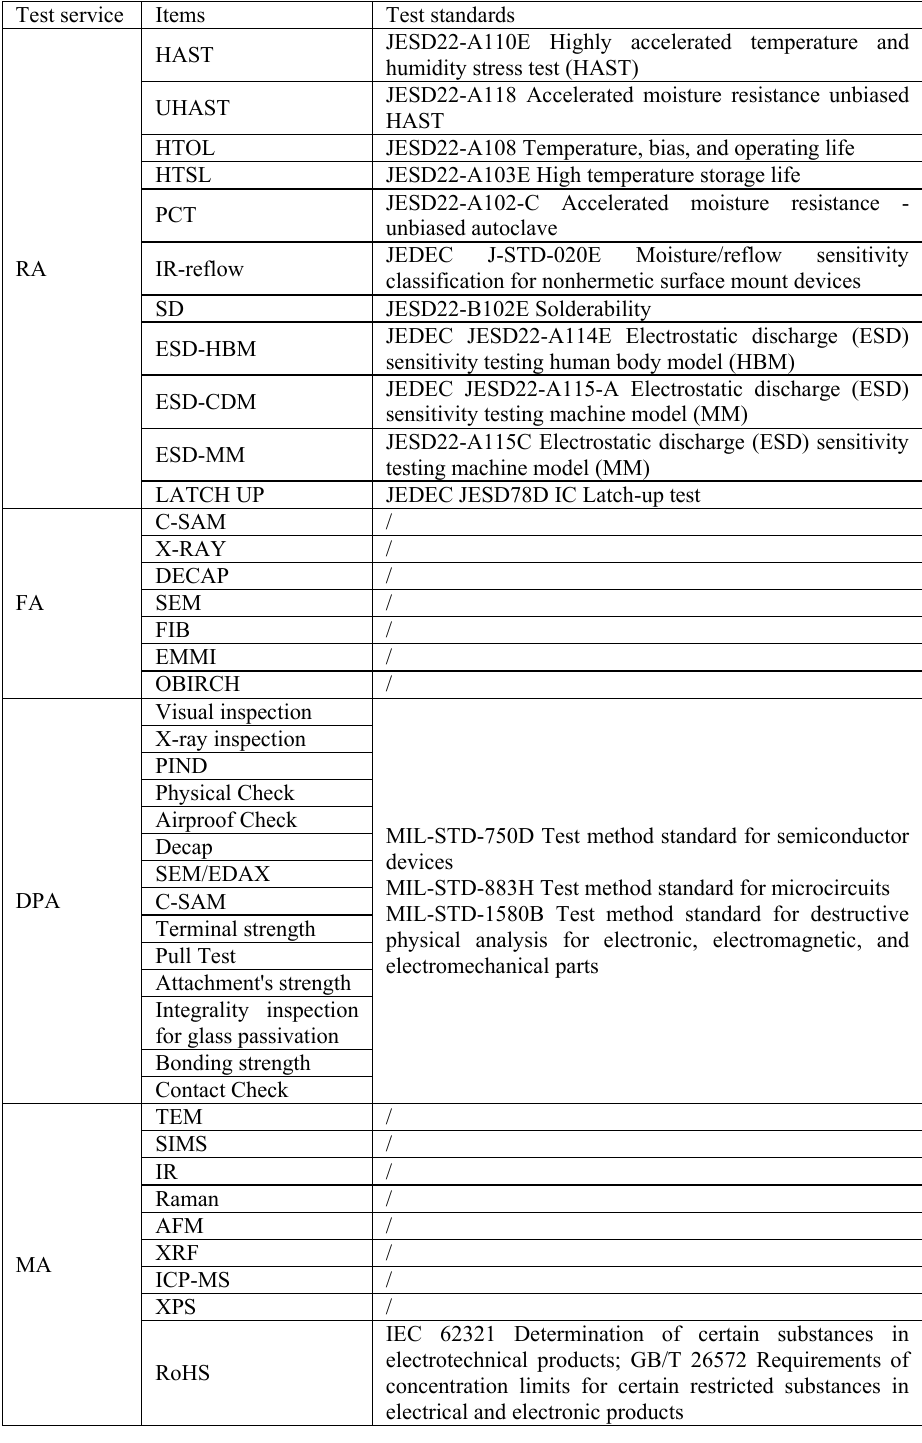
Table 2. Typical test items in IC